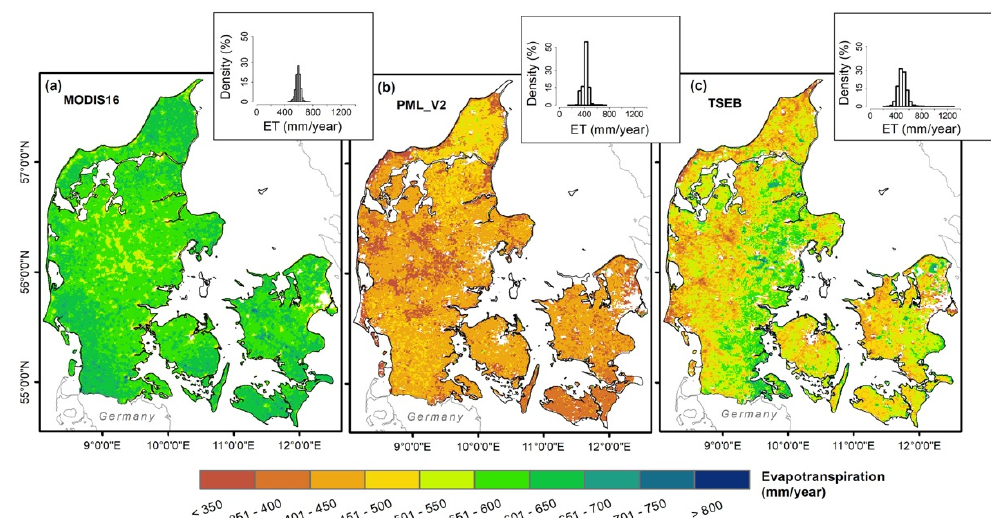
Remote Sens. 2021 , 13 , x FOR PEER REVIEW Figure 3. Grid-based satellite remote-sensing evapotranspiration (RS ET) distributions (1 km spatial resolution) along with the histogram of the mean annual ET (50 mm/year bins): ( a ) MODIS16, ( b ) PML_V2, and ( c ) two-source energy balance model (TSEB). The urban areas have been masked out in the maps (see Figure 2a for details).